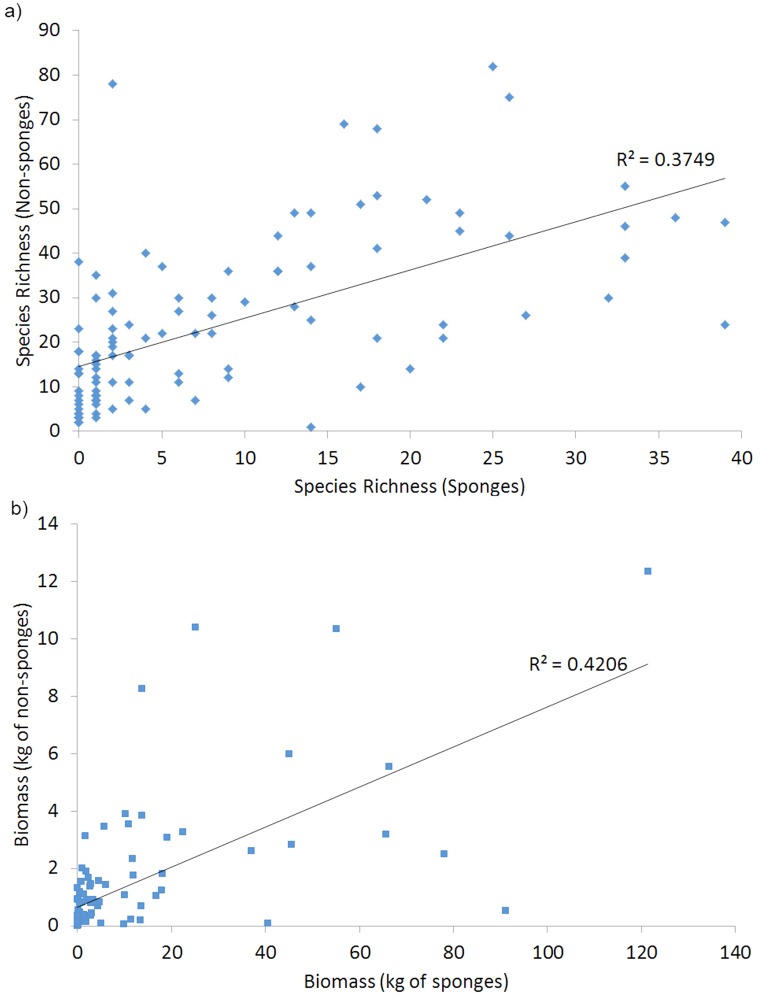
Relationship between sponges and other taxa based on a) richness and b) biomass, the latter excluding outliers due to weight of hard corals collected at station 16BS04 from SOL5650 (23.4 kg hard corals) and station 55BS35 from SOL5117 (100.9 kg hard corals).